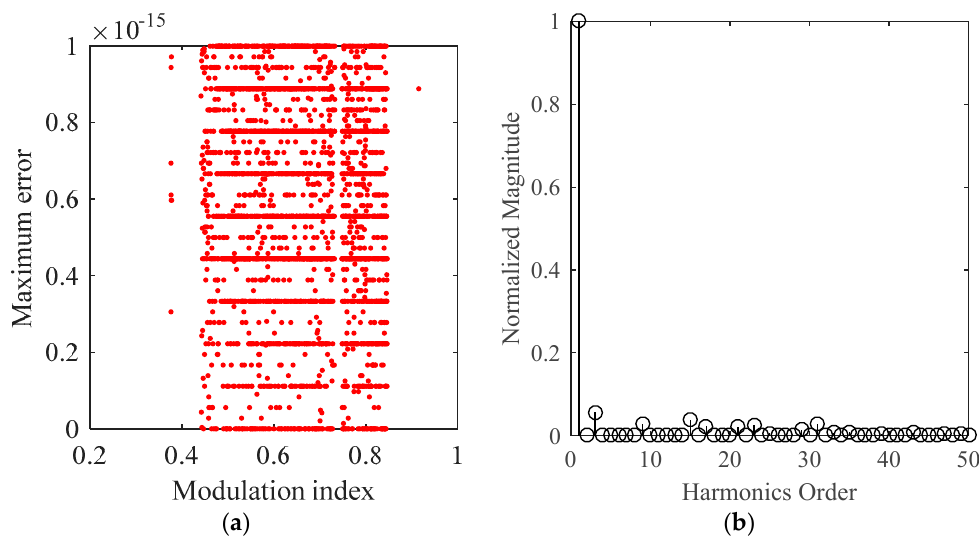
Figure 8. ( a ) Maximum error in the function for pattern “ a ”; ( b ) harmonics profile at M = 0.845.